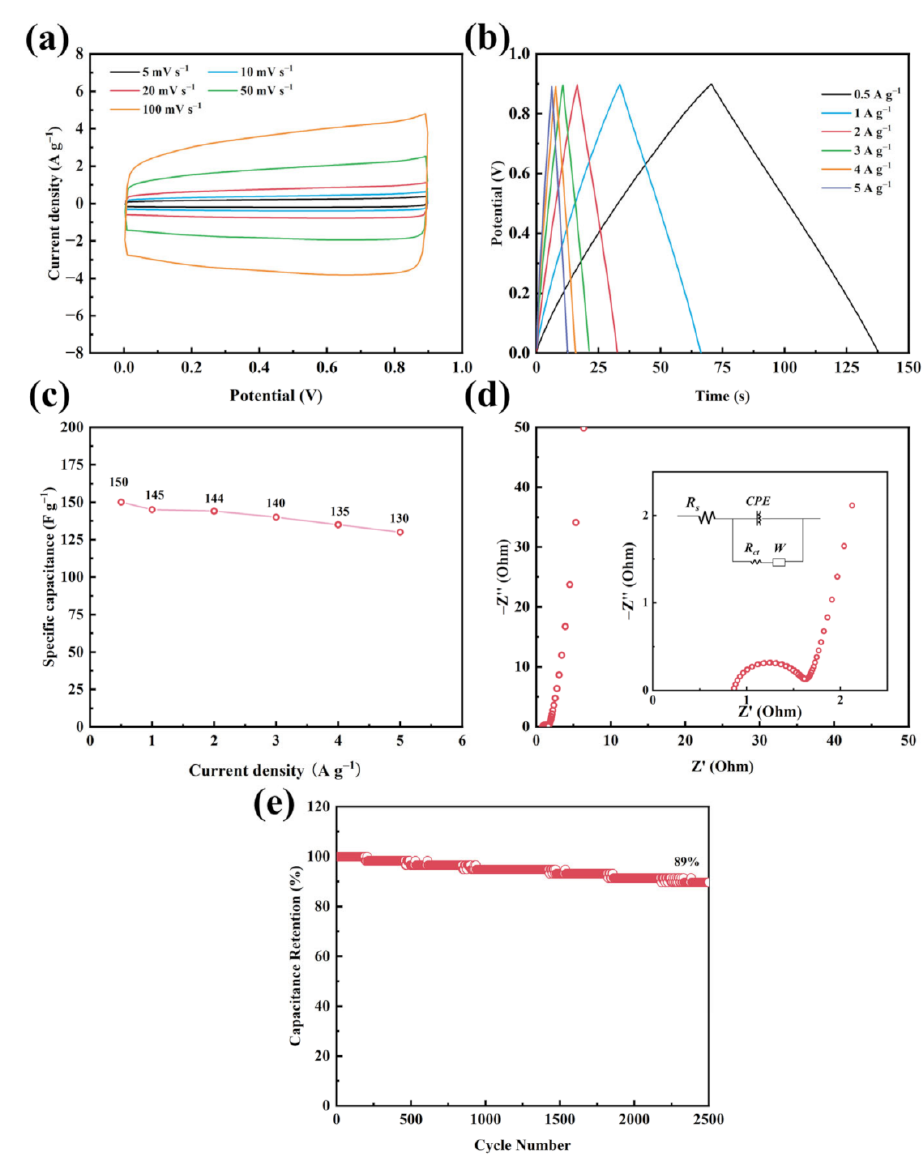
Figure 7. ( a ) CV curves, ( b ) charge/discharge profiles, ( c ) rate performance, ( d ) Nyquist plots and, ( e ) cycle stability tests at 1 A g − 1 of ZnFe 2 O 4 /rGO − 2 for symmetrical